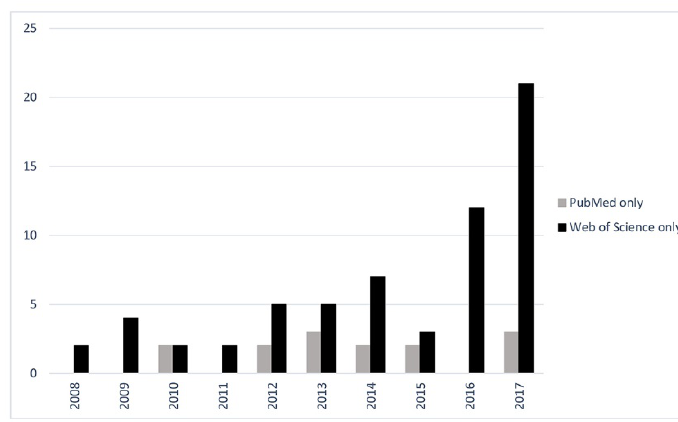
Figure 2 Unique publications by data source per year